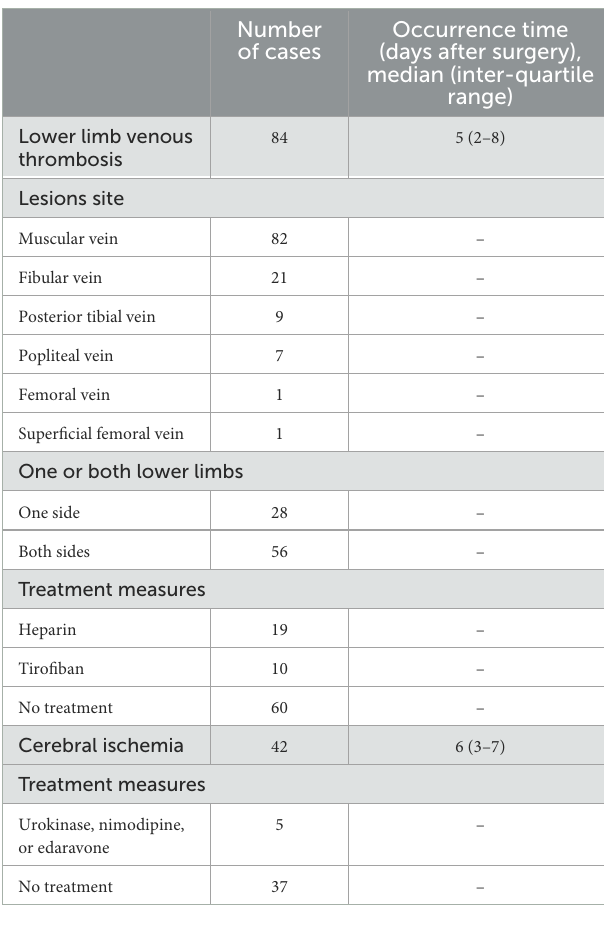
TABLE 1 Characteristics of the postoperative thrombosis-related